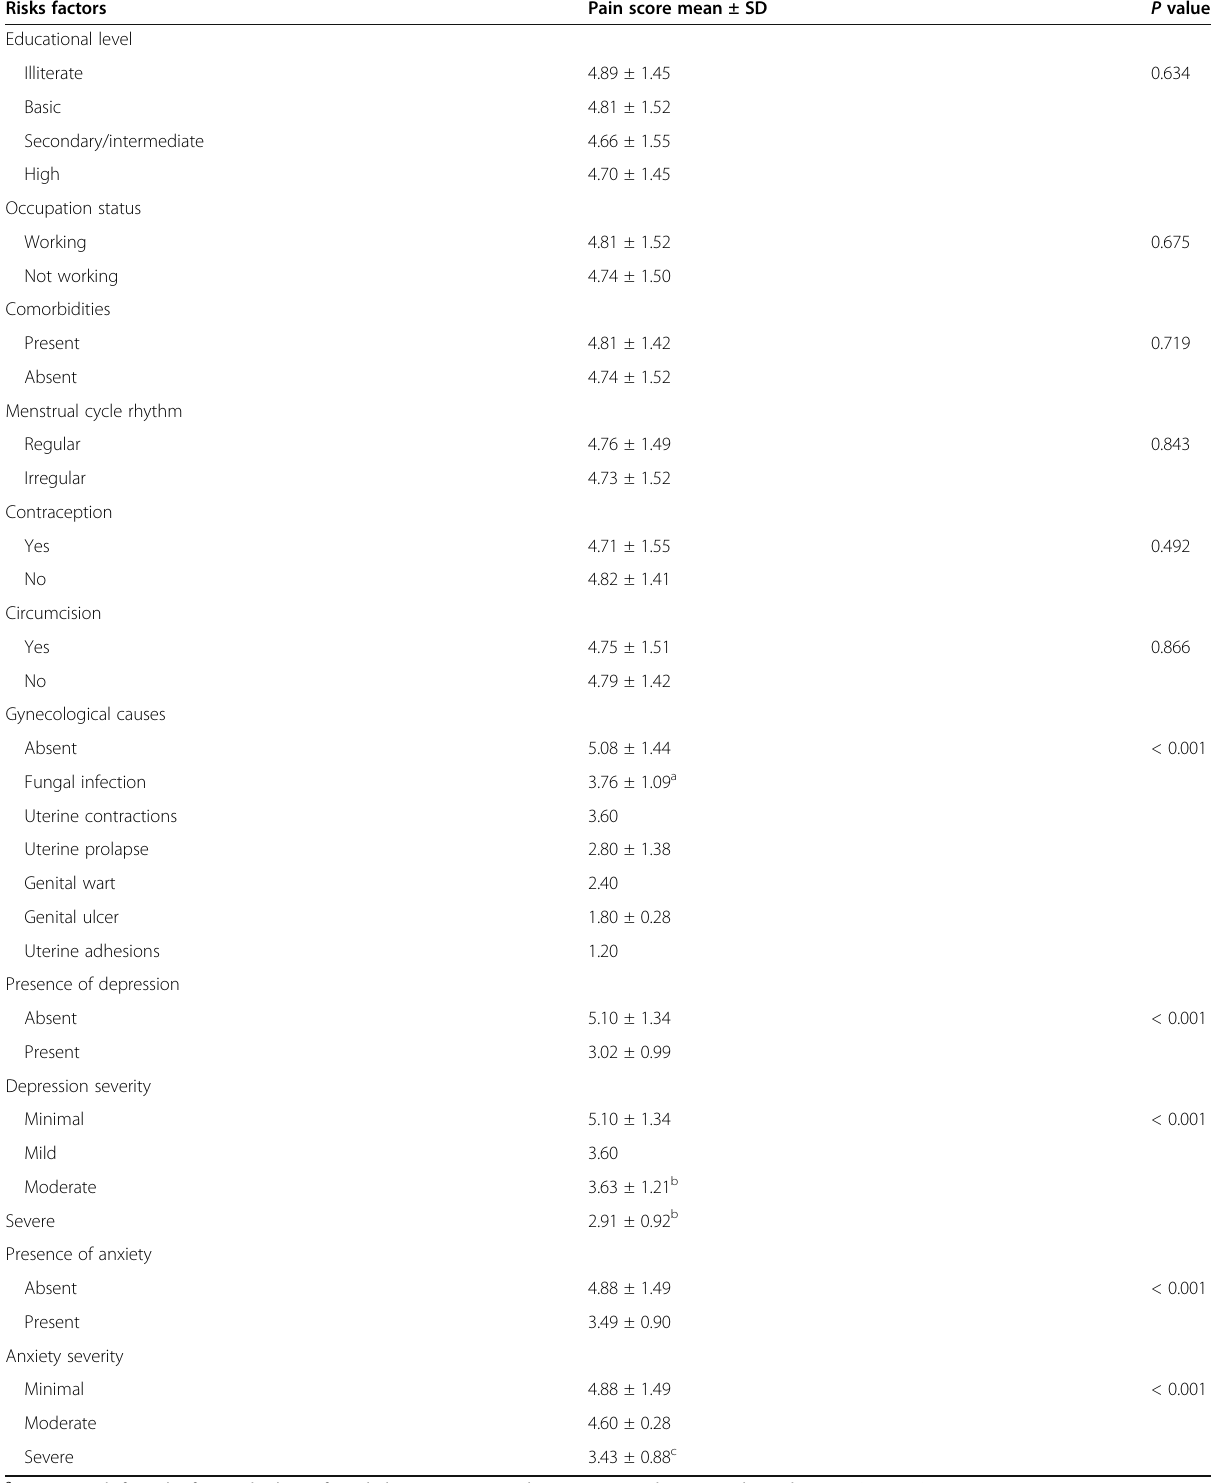
Table 3 Association of the pain score with different risk